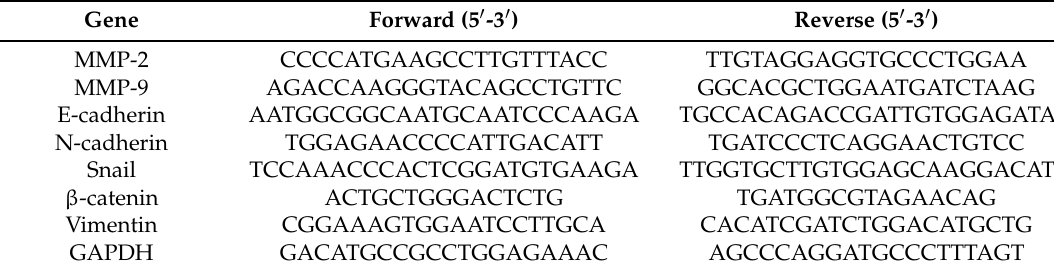
Table 1. Sequences for real-time RT-PCR